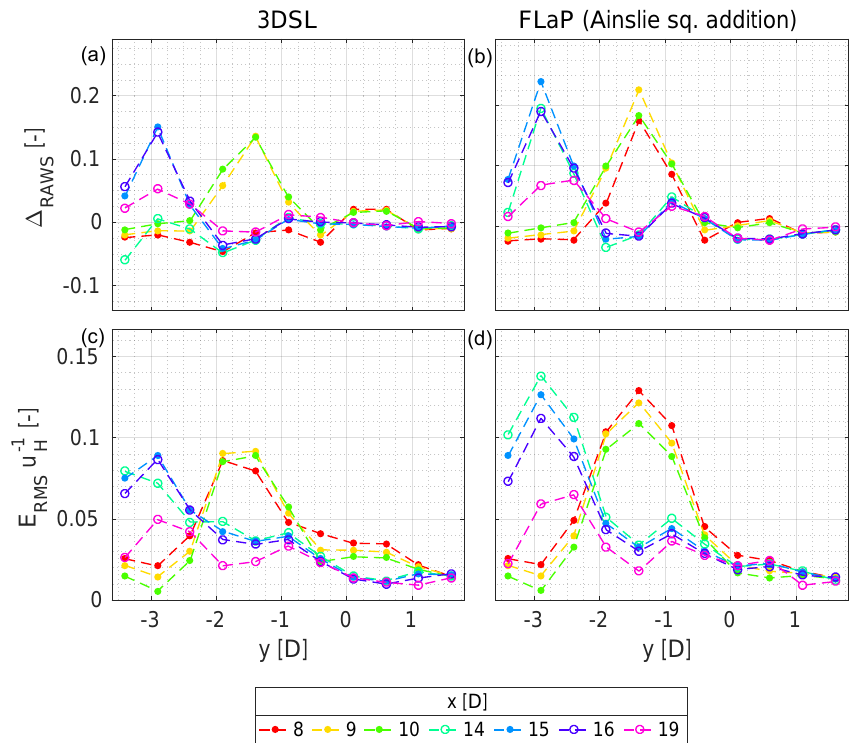
Figure 11. Test case 4 (multiple wakes with 1.5 D lateral separation). Deviation of the rotor-average wind speed (cid:49) RAWS (a, b) and of the root mean square error E RMS (c, d) evaluated in relation to the large-eddy simulation wind field for the simulation with the 3DSL model and with